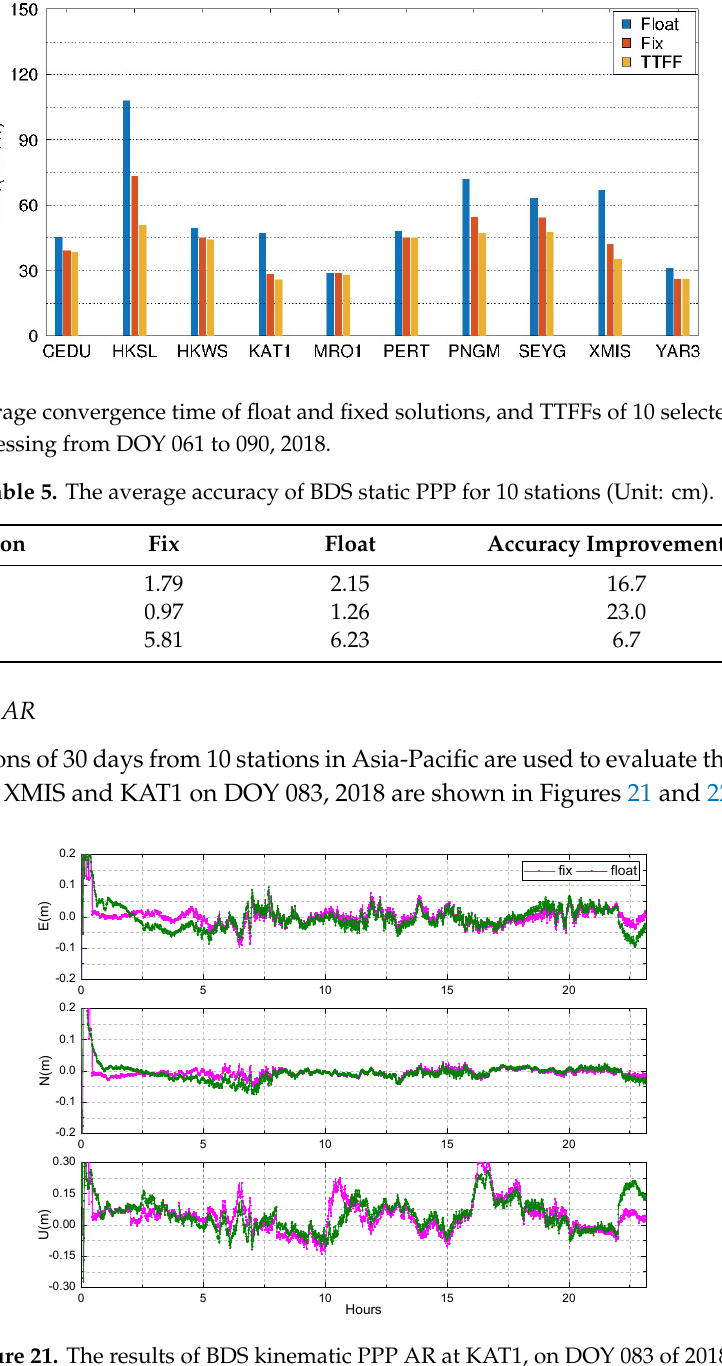
Figure 21. The results of BDS kinematic PPP AR at KAT1, on DOY 083 of 2018.